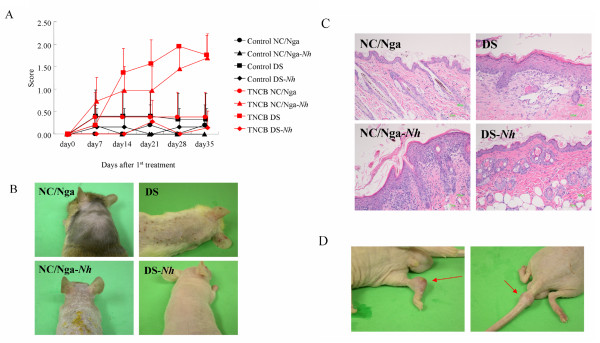
Repeated application of TNCB in DS, DS-Nh, NC/Nga and NC/Nga-Nh mice. (A) Evaluation of dermatitis in these mice. Each value represents mean ± SD of four or five mice. (B and C) Clinical features of skin in these mice. (D) Clinical features of joints in DS-Nh mice. Arrows indicate arthritis-like lesions.